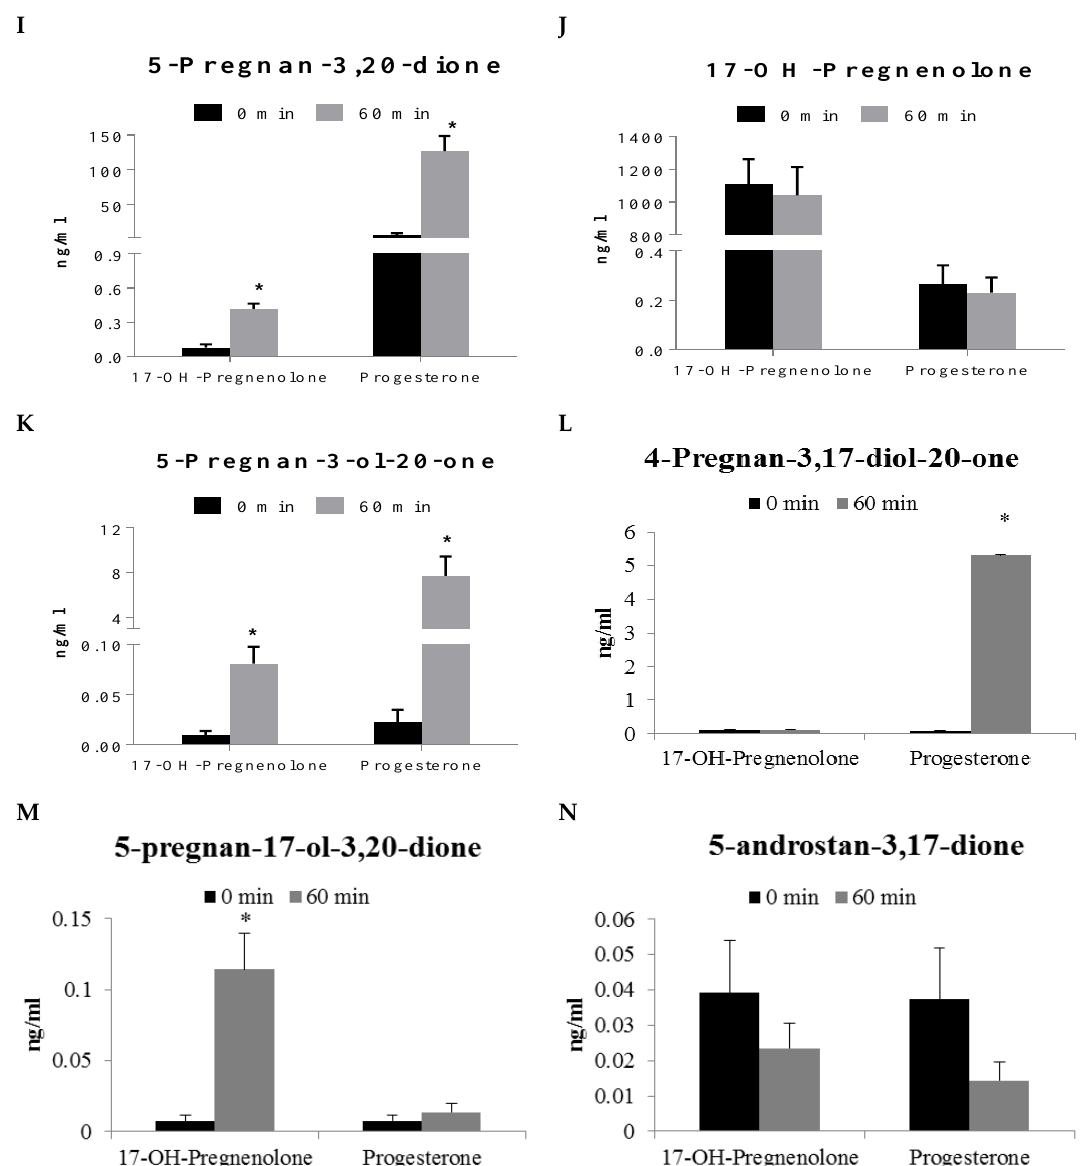
Figure 3. Steroid formation (ng/mL) in human prostate tissue (peripheral zone, N = 9) homogenate following 60 min incubation with 2 μg/mL progesterone and 17-OH-pregnenolone precursors. Each of these panels represents the levels of a particular steroid formation. Results are expressed as mean ± SEM of nine different tissues. * represents statistically significant difference ( p < 0.05) between 0 and 60 min incubations of human prostate homogenate with either 17-OH-pregnenolone or progesterone.